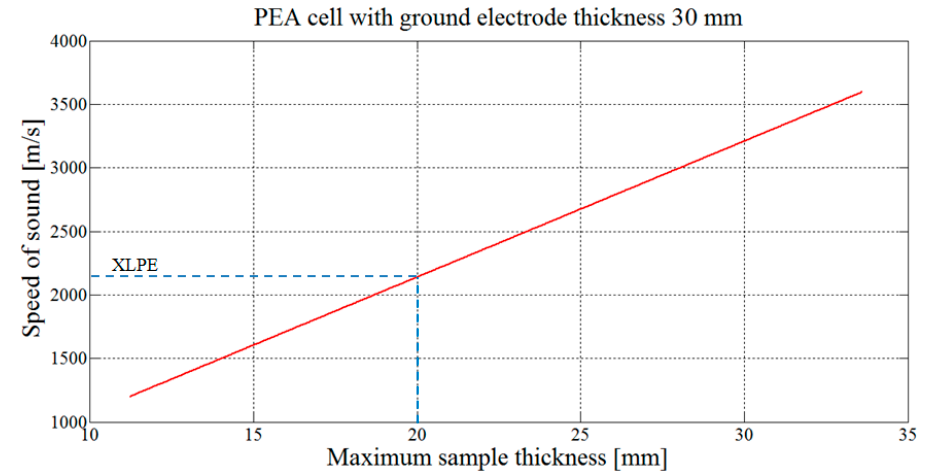
Figure 8. Graph useful to determine the maximum sample thickness that can be tested without reflections in the main output signal, on the basis of the 30 mm thick ground electrode.